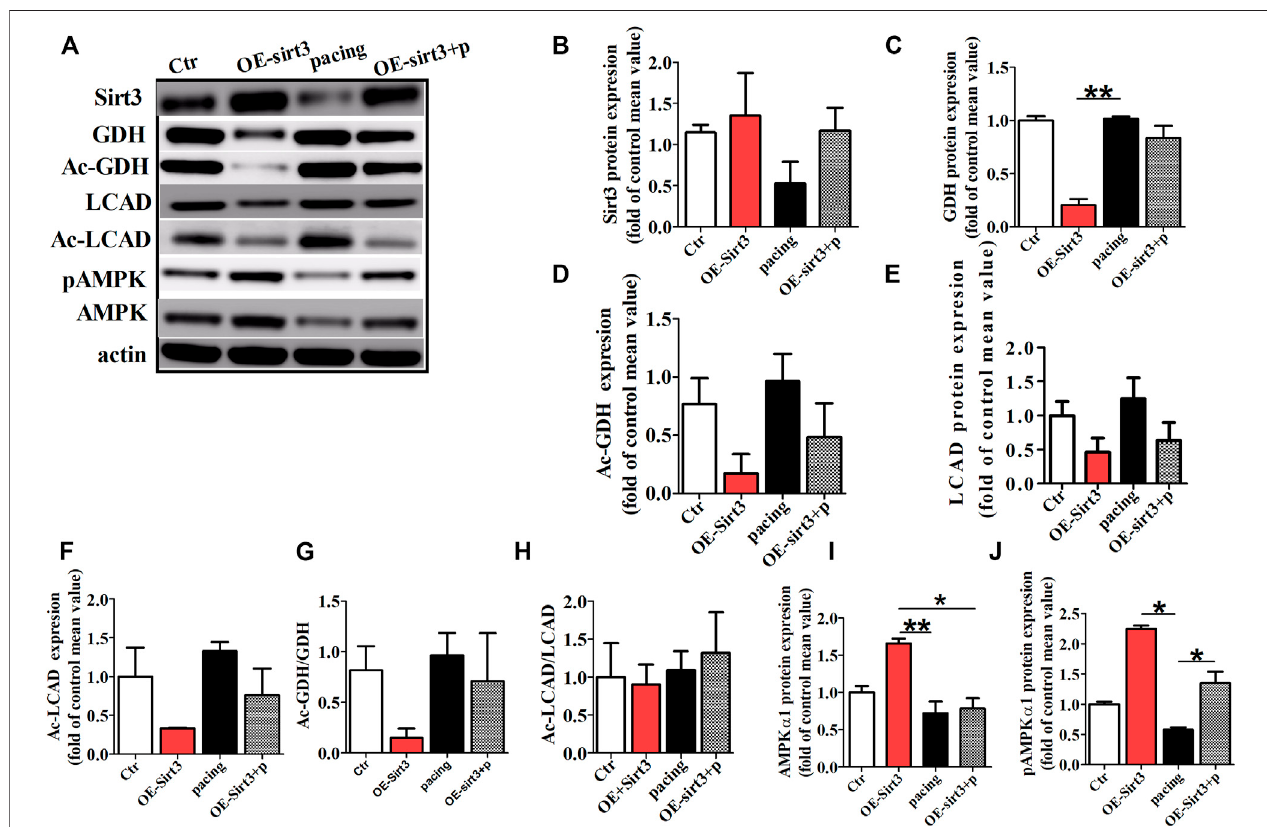
FIGURE 6 | The acetylation level of key metabolic enzymes controlled by Sirt3 pathway in vitro . (A) Representative bands for the protein expression of Sirt3, GDH, Ac-GDH, LCAD, Ac-LCAD, pAMPK, AMPK in the HL-1 cells of all groups. (B,C,E,I,J) Statistical analysis of Sirt3, GDH, LCAD, pAMPK1 α and AMPK1 α expression. (D,F,G,H) Statistical analysis of Ac-GDH, Ac-LCAD, Ac-GDH/GDH, Ac-LCAD/LCAD. * p < 0.05, ** p < 0.01, n = 3 each group.